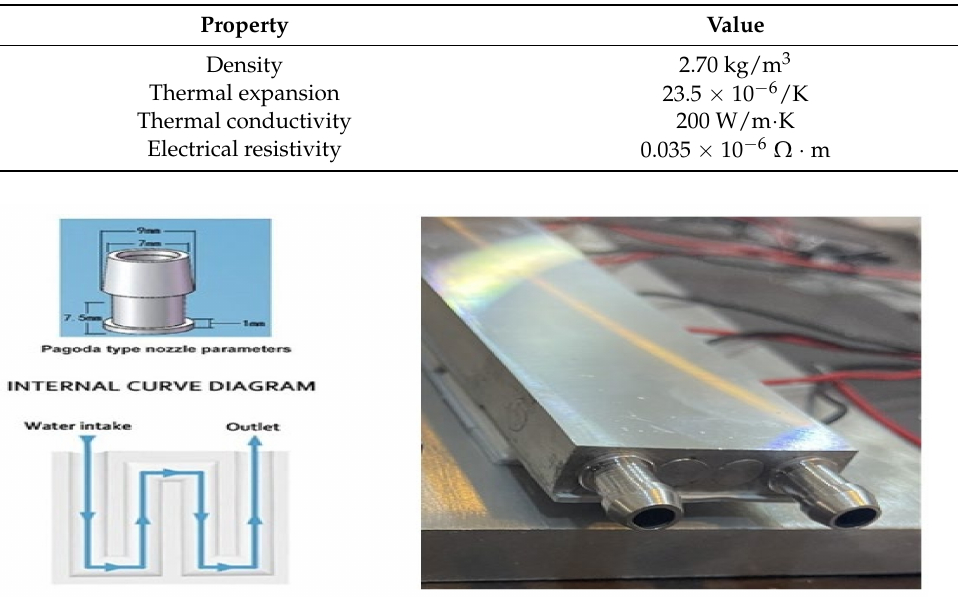
Figure 3. The practical configuration of the lower aluminum block with an M-shaped water